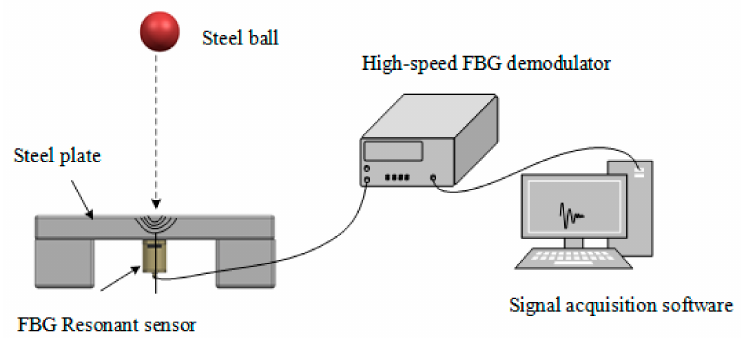
Figure 6. Natural frequency measuring device’s design picture of free vibration